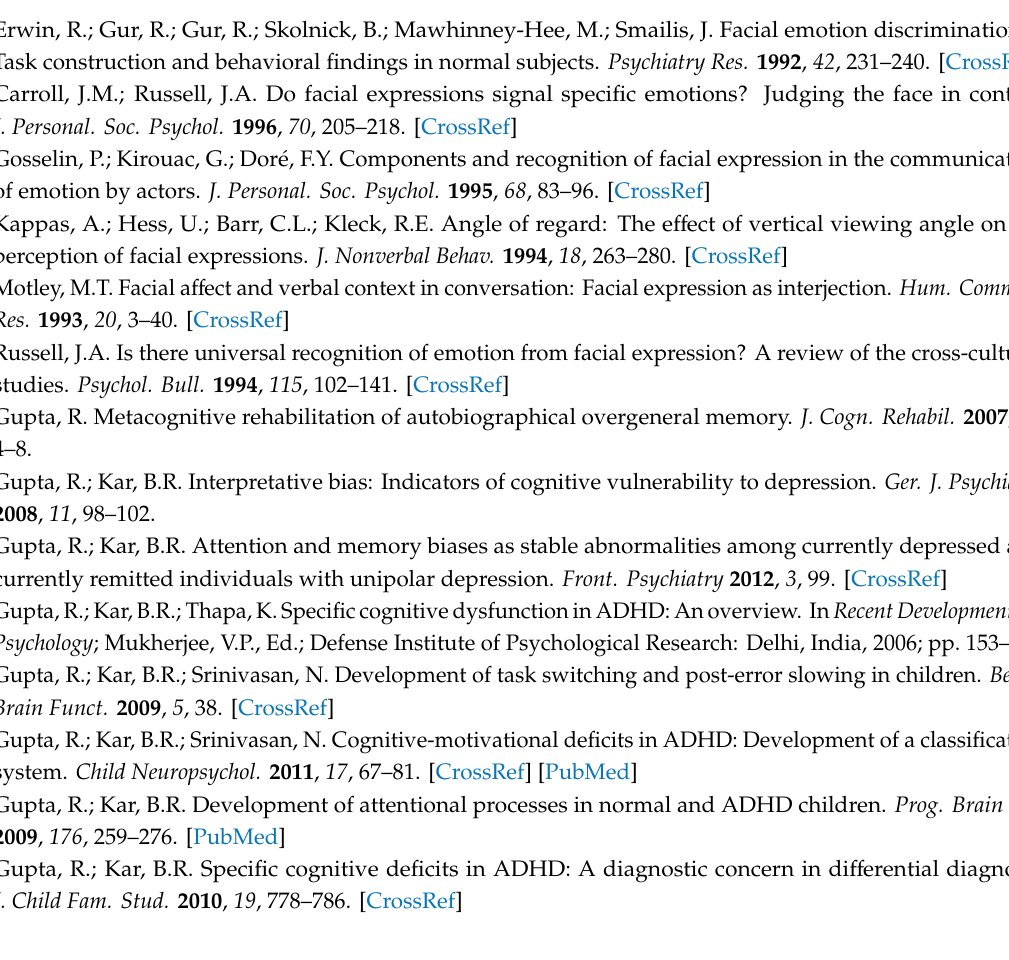
Table S1: Portuguese normative data of the Radboud Faces